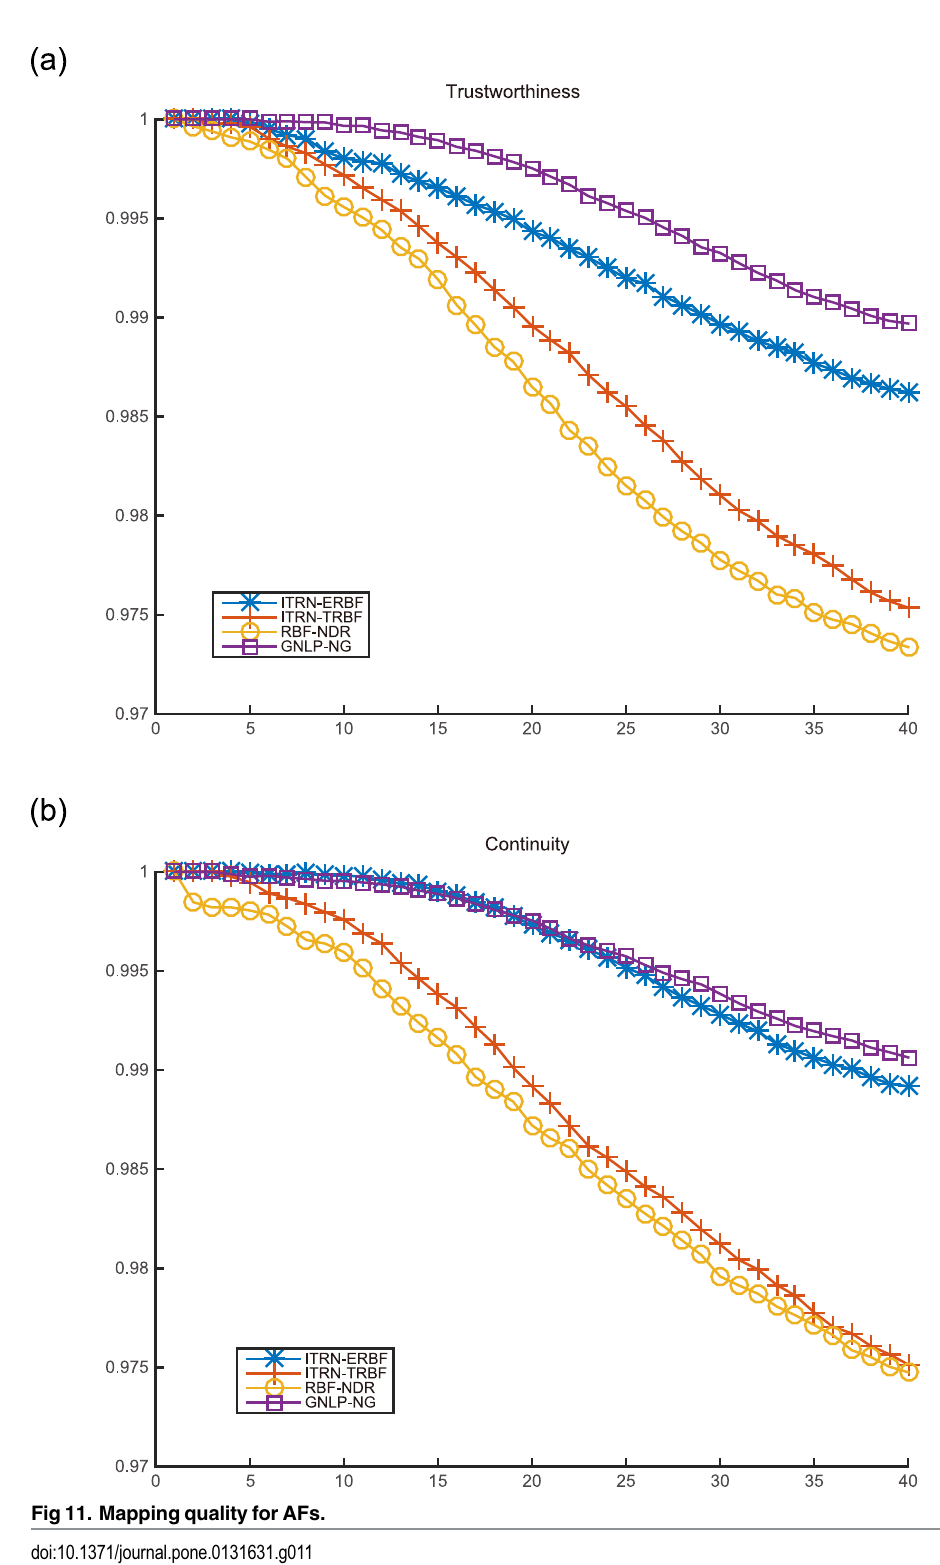
Fig 11. Mapping quality for AFs.